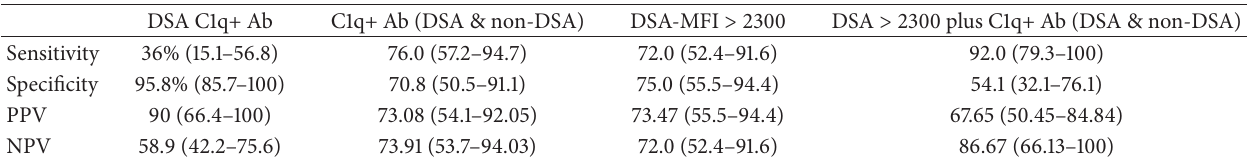
Table 2: Sensitivity, specificity, PPV, and NPV of DSA C1q+ Ab; C1q+ Ab (DSA and non-DSA); DSA LABScreen SAB MFI > 2,300; and DSA > 2,300 plus C1q+ Ab (DSA and non-DSA).